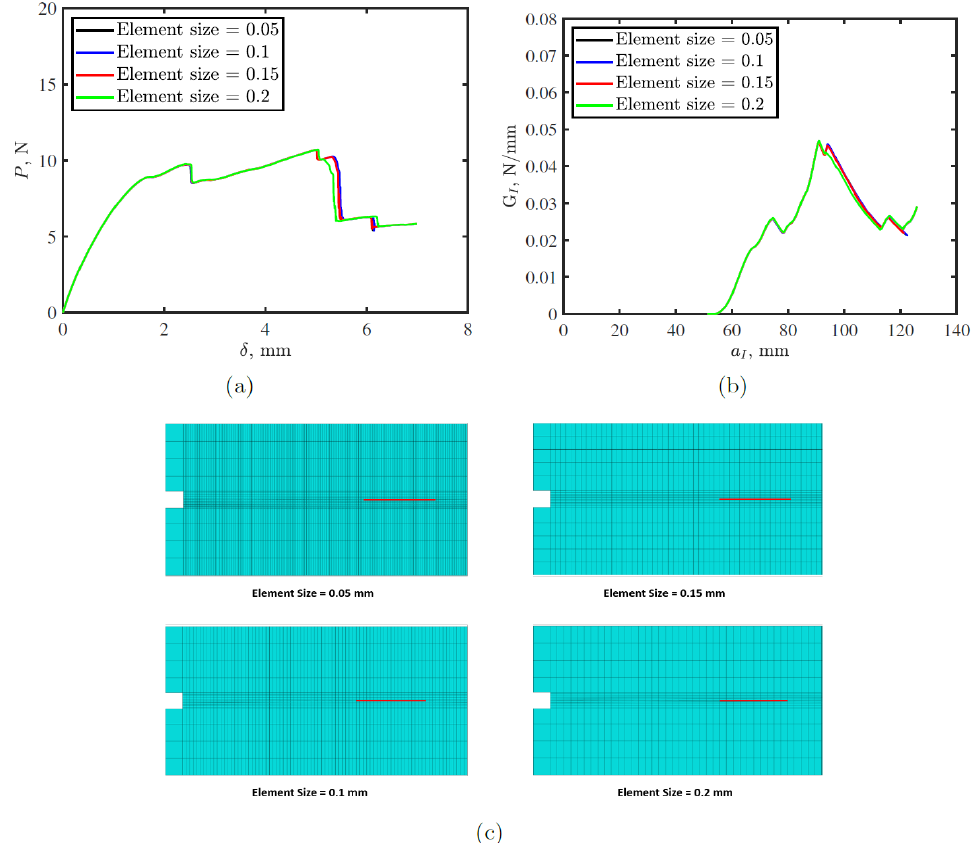
Figure 5. Mesh sensitivity analysis for double cantilever beam (DCB) tests on toughened thermoplas- tic adhesive tape with 2 mm sacrificial defect and 5 mm gap: ( a ) load-displacement (P- δ ) response; ( b ) fracture toughness, G I -crack length, a I response (R-curve); and ( c ) meshes with different element sizes. the red lines in c represent the